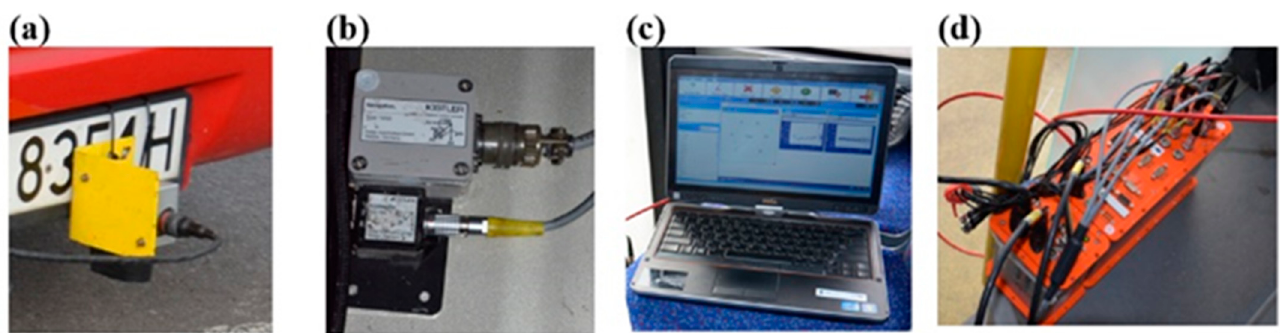
Figure 1. Measurement system during acceleration and braking maneuvers: ( a ) optoelectronic sensor, ( b ) acceleration sensors, ( c ) control tablet with software, ( d ) data acquisition station.